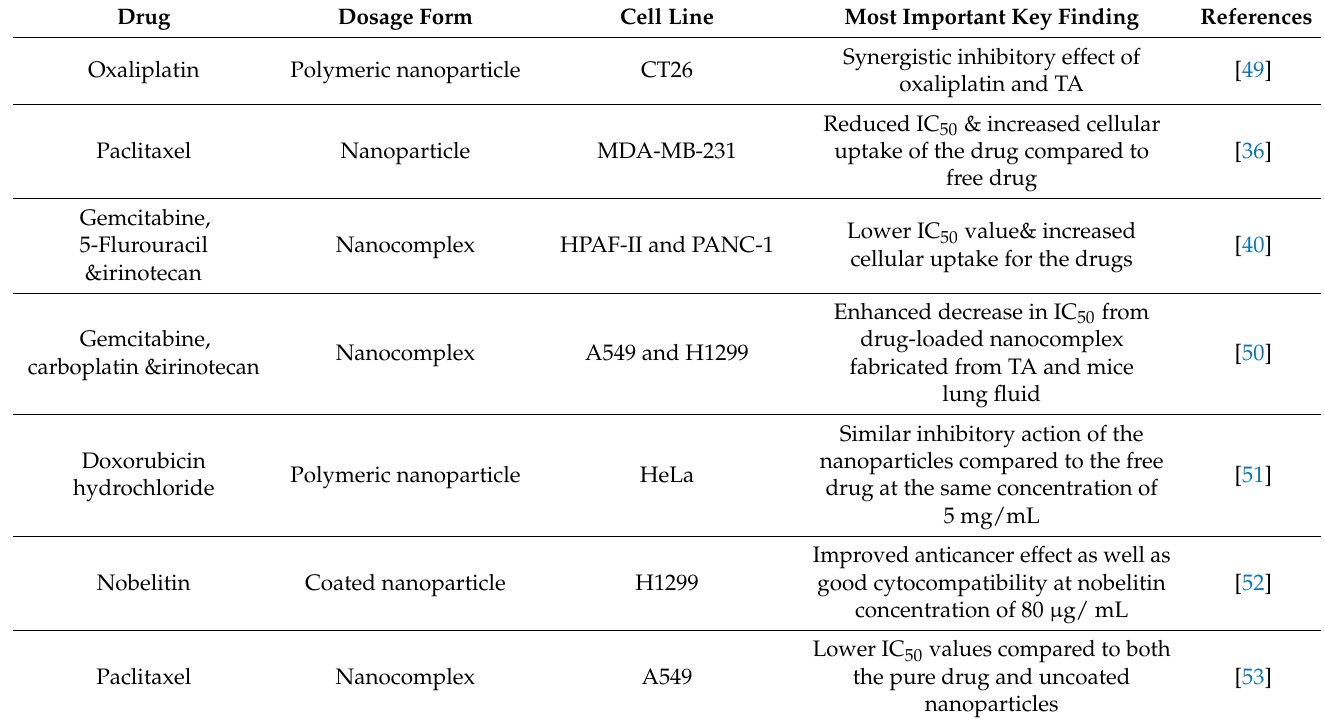
Table 2. Examples of several combinational Approaches of TA and other anticancer agents.